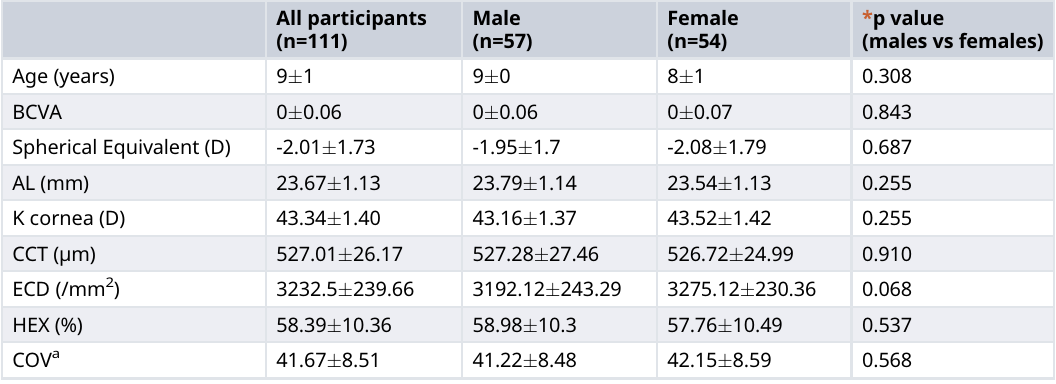
Table 1. Participant demographic profile.